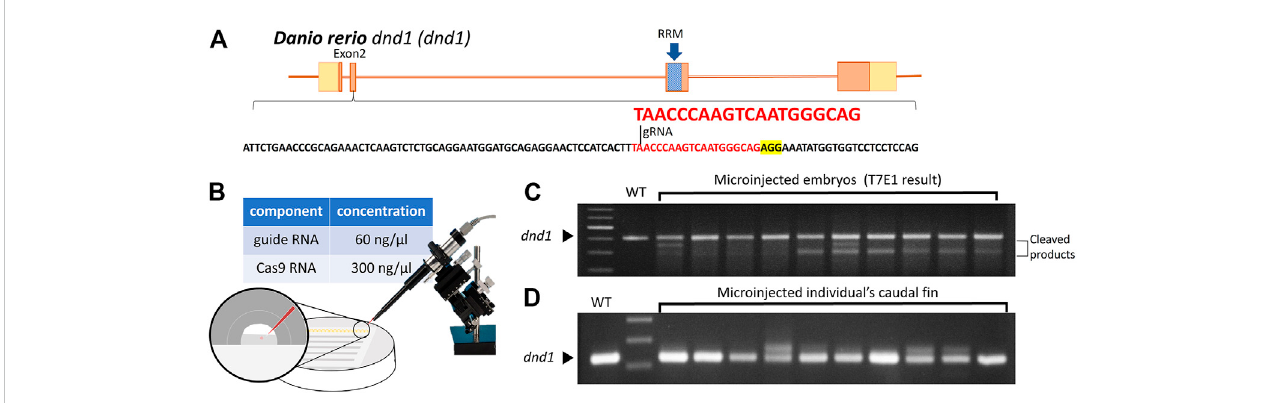
FIGURE 1 (A) DesignoftheCRISPR/Cas9targetsitesoftheguideRNA(gRNA)in dnd1 .ThegRNAwasdesignedinexon2,andthetargetsiteofthegRNAisindicated inred, while thesequence highlightedinyellow is PAM.The RNA-recognitionmotif (RRM) istheconserved functional domain encoded byexon 3of the dnd1 gene. (B) Microinjectionschematicwiththecomponentandconcentrationoftheworkingsolution. (C) Mutationidenti fi edineachF 0 generationbyT7E1using